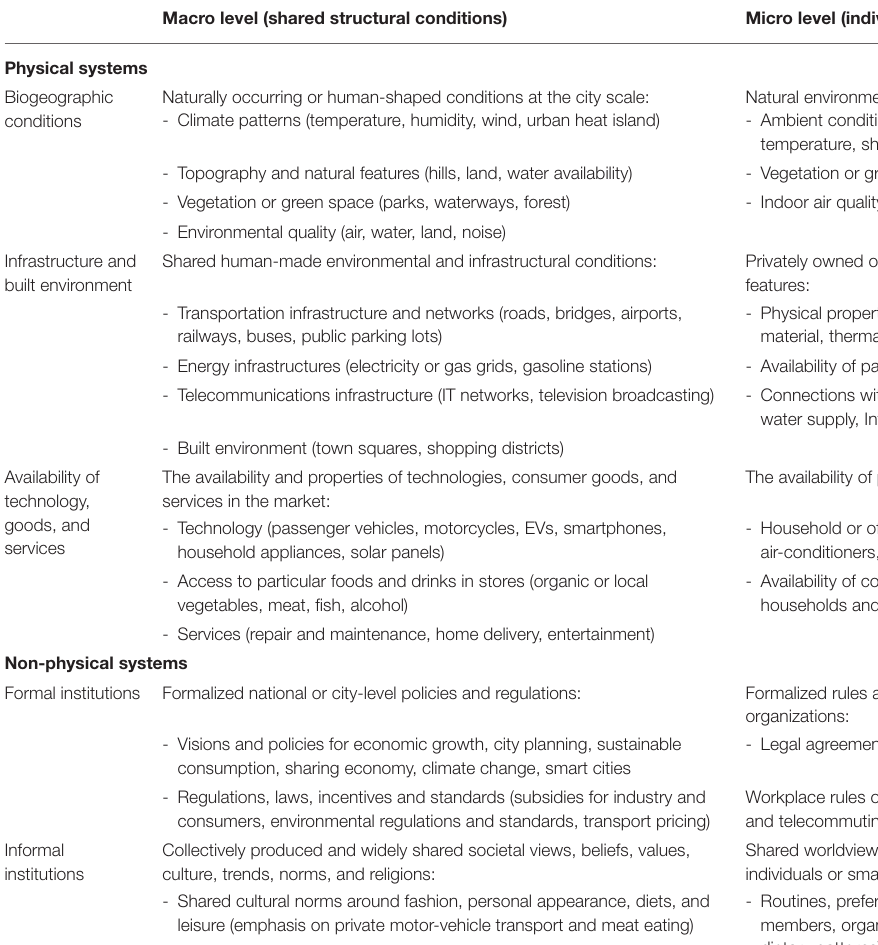
TABLE 1 | Framework of lock-in factors affecting individual urban